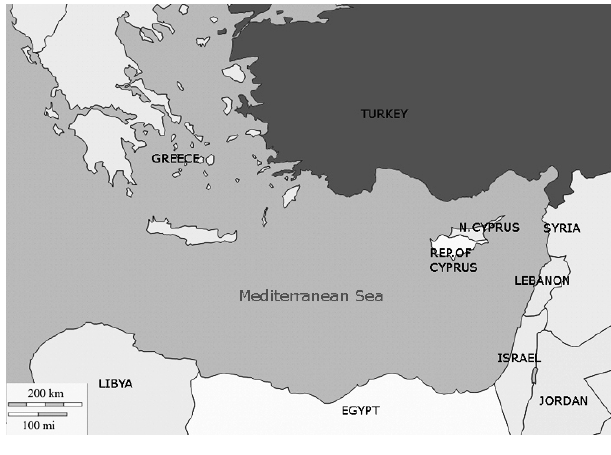
Fig. 2 . Map of the east Mediterranean